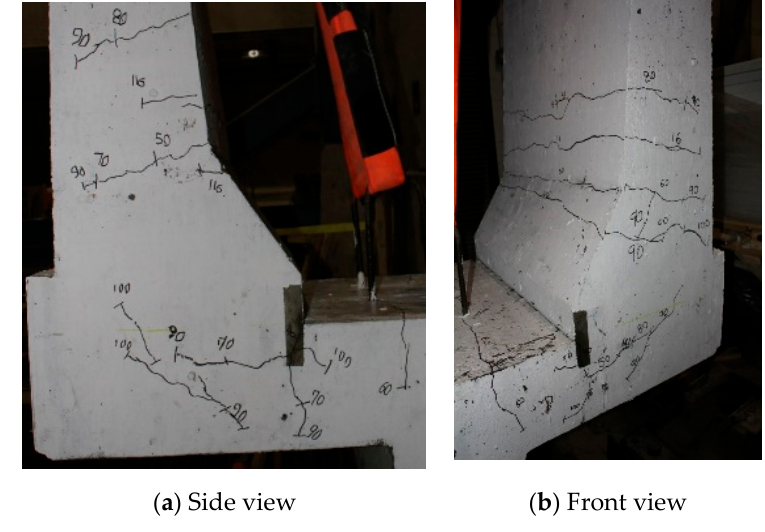
Figure 18. Specimen # 3: crack pattern. ( a ) Side view; ( b ) front view.